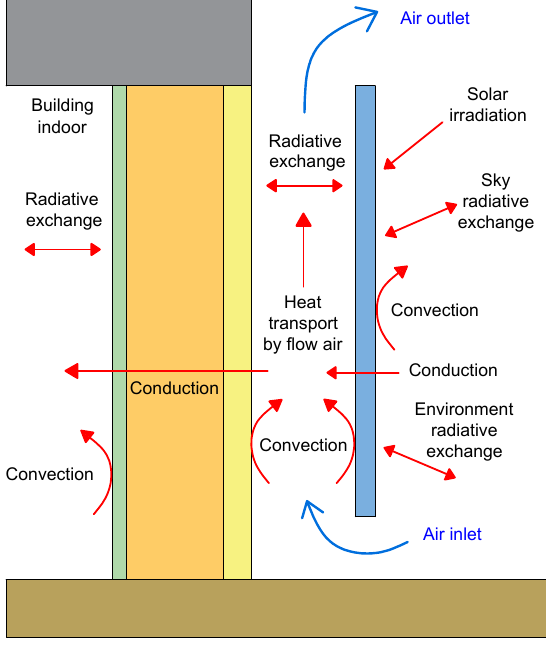
Figure 5. Heat transfer in the opaque ventilated